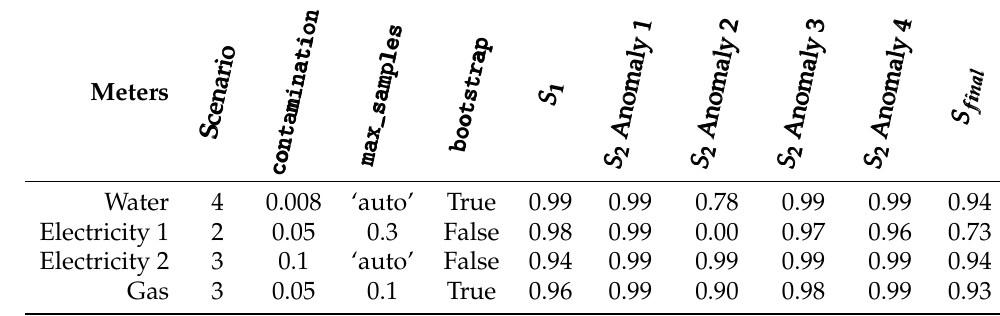
Table 5. Best results for each meter with the IF algorithm, according to the proposed metric, among all scenarios and considering the mentioned grid-search.